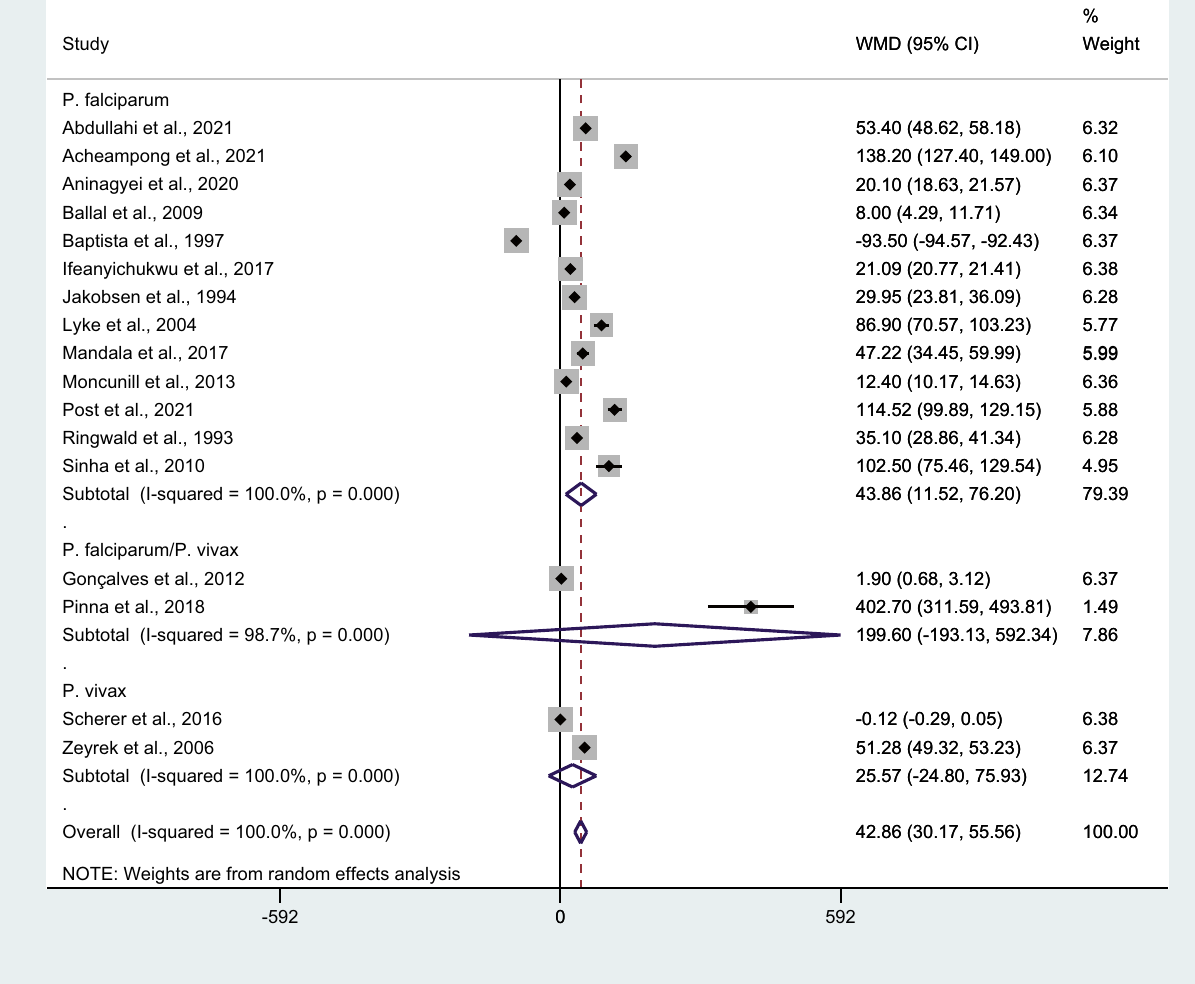
Figure 9. Differences in IL-6 levels between patients with uncomplicated malaria and controls by Plasmodium spp. Abbreviation: WMD, weighted mean difference; CI, confidence interval; black diamond symbol, point estimate; solid line in the middle of the graph at 0, zero effect size; Dashed red line: pooled WMD between the two groups; I 2 , level of heterogeneity; P = 0.000 or less than 0.05, significant